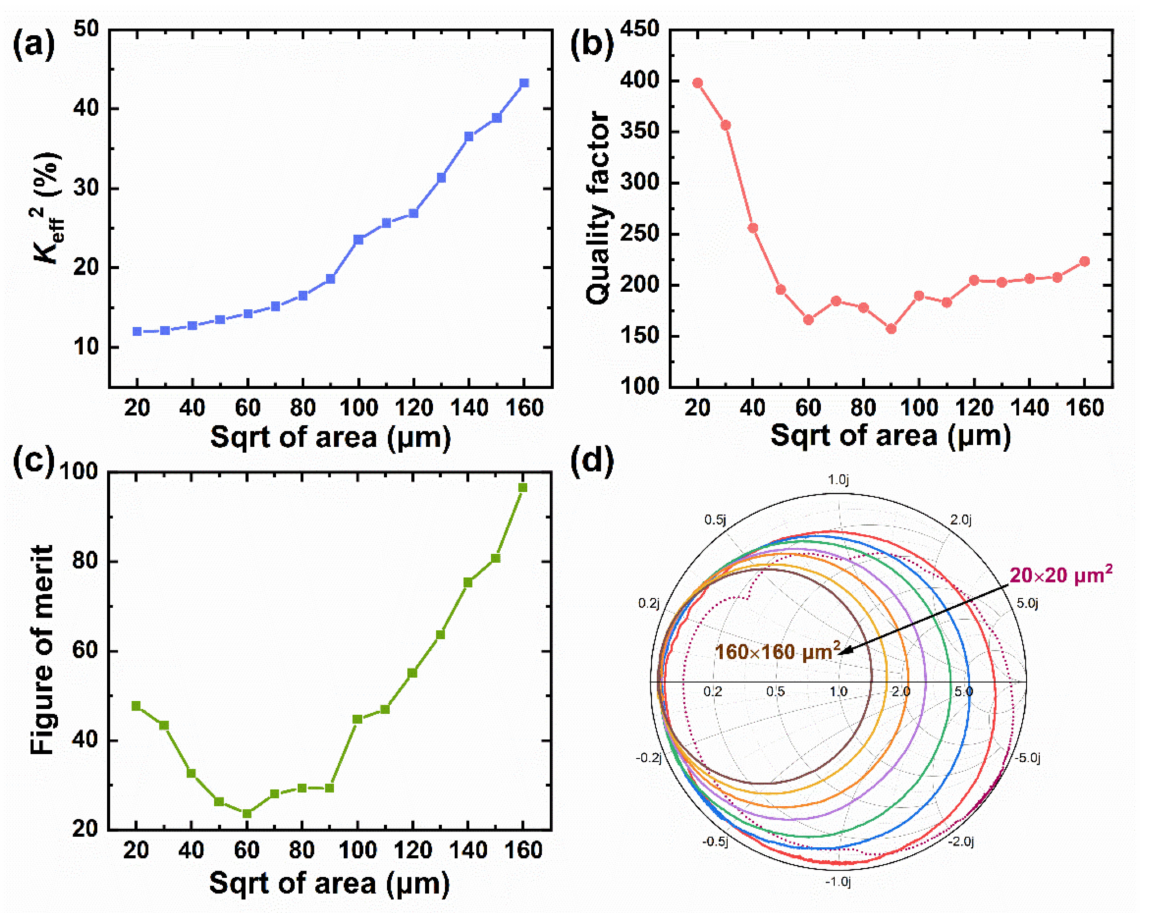
Figure 3. Measured performance of resonators with resonant areas from 20 × 20 µ m 2 to 160 × 160 µ m 2 . ( a ) Effective electromechanical coupling coefficients; ( b ) Quality factors; ( c ) Figure of merit; ( d ) Smith circles of